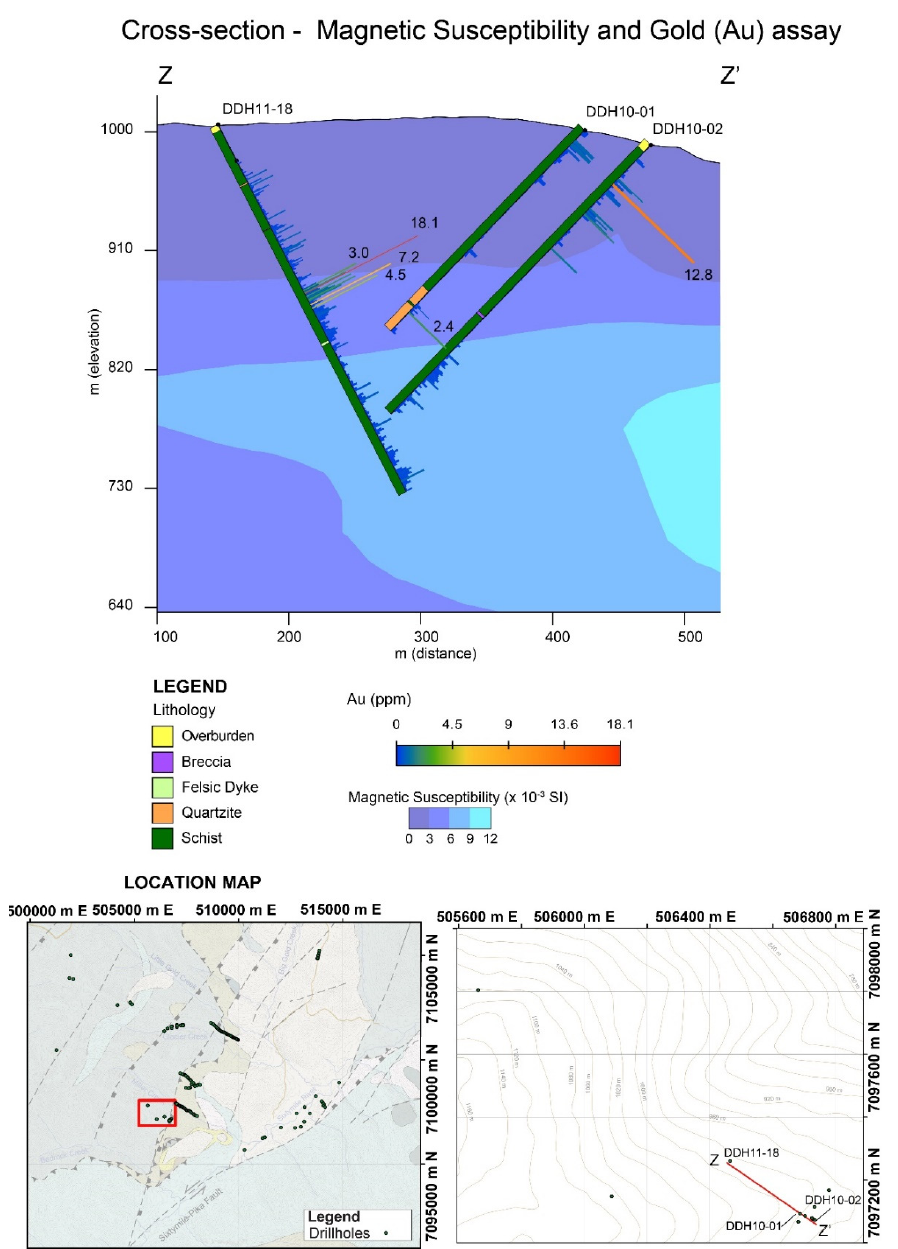
Figure 16. Drillholes on the ridge to the SW of the Miller Creek area showing gold (Au) assay values and schists that coincide with low magnetic susceptibility values. The length of bins on the bar graphs that are superimposed on the drillholes are proportional to the measured Gold (Au) grade at the corresponding depth. The assay values are also indicated by the color